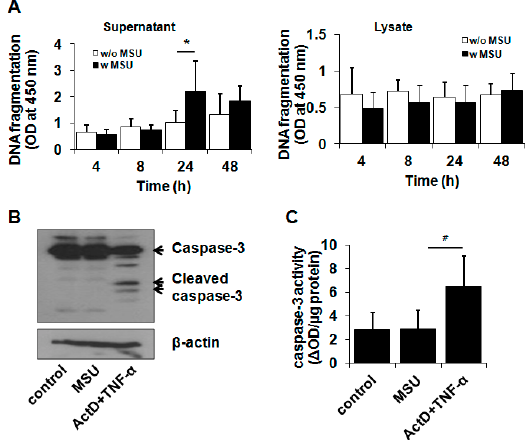
Figure 2. MSU crystal-induced chondrocyte death was not dependent on the apoptosis pathway. ( A ) The effect of MSU crystals on DNA fragmentation in primary human